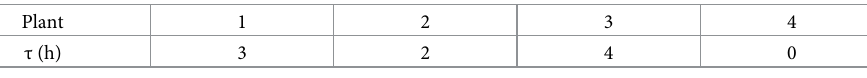
Table 2. Time delay of the plant transform to direct downstream plant.